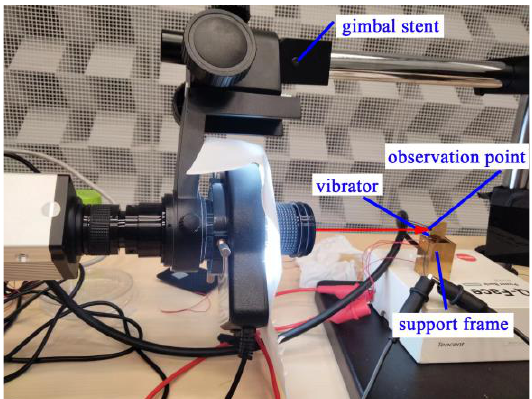
Figure 11. A partially enlarged view of the test component.